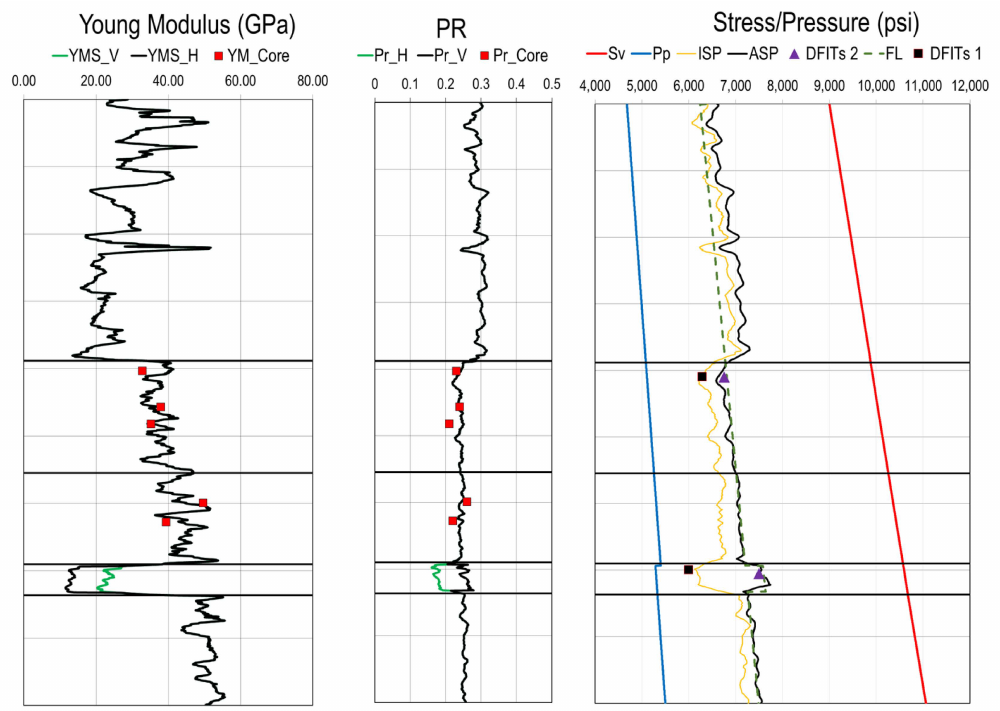
Figure 17. From left to right: calibrated static Young’s modulus (horizontal and vertical), calibrated static Poisson’s ratio, isotropic and anisotropic stress profiles with frictional limit stress